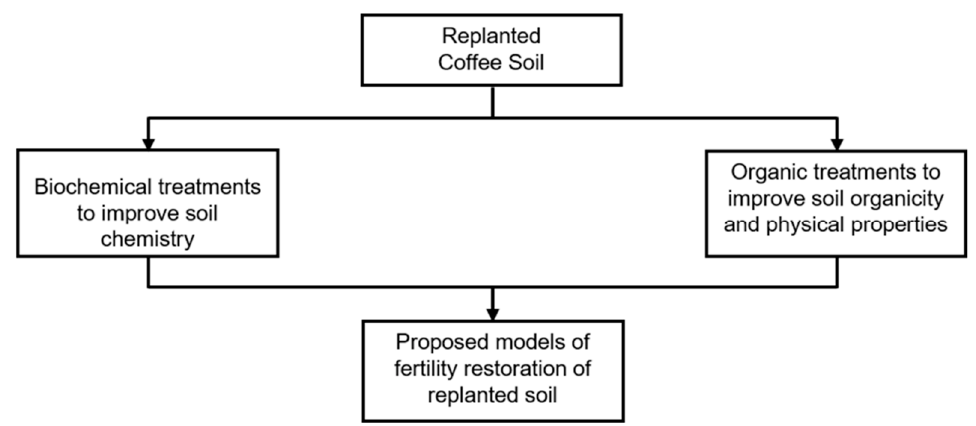
Figure 1. Flow chart of research on supplementing the loss of nutrient cycling for replanted coffee soil.